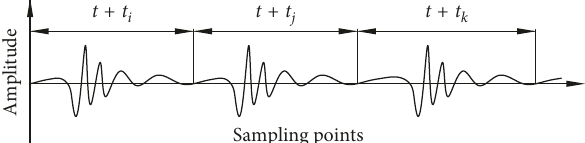
Figure 2: Quasi-periodic signal. t is the average period and t and t k denote the periodic deviations.